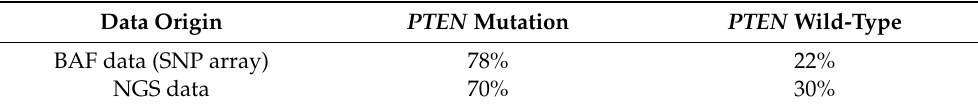
Table 1. Ratio of PTEN mutation and wild-type alleles from SNP array and NGS